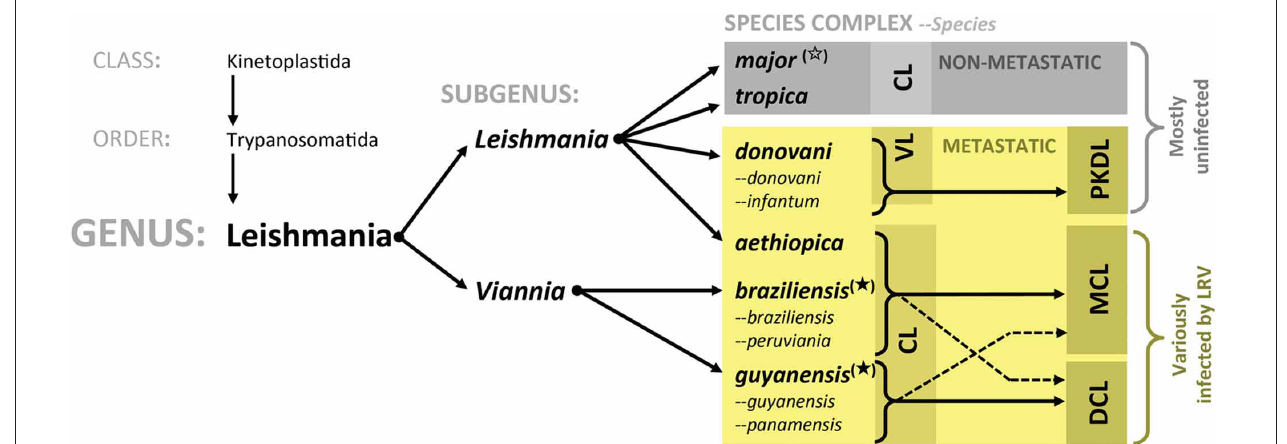
FIGURE 1 | Leishmanial phylogeny and LRV presence. Intrinsic parasite factors underlying clinical disparities in metastatic leishmaniasis. Species listed are those relevant to this text. The L. mexicana species complex (of the L. leishmania subgenus) was omitted for simplicity; thus far, no LRV has been reported in their member species. CL , Cutaneous leishmaniasis; DCL ,